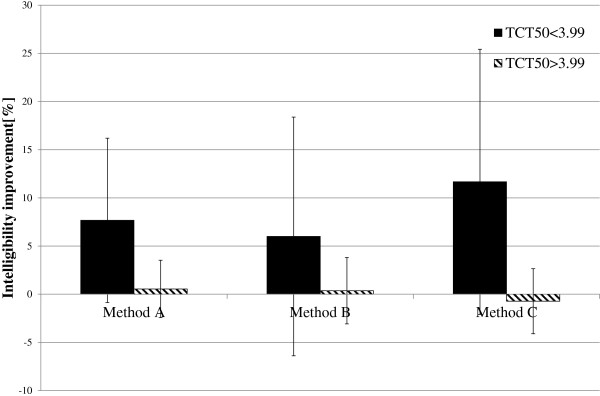
Average improvement in WER for input speech with average rate equal to ROSmean4.